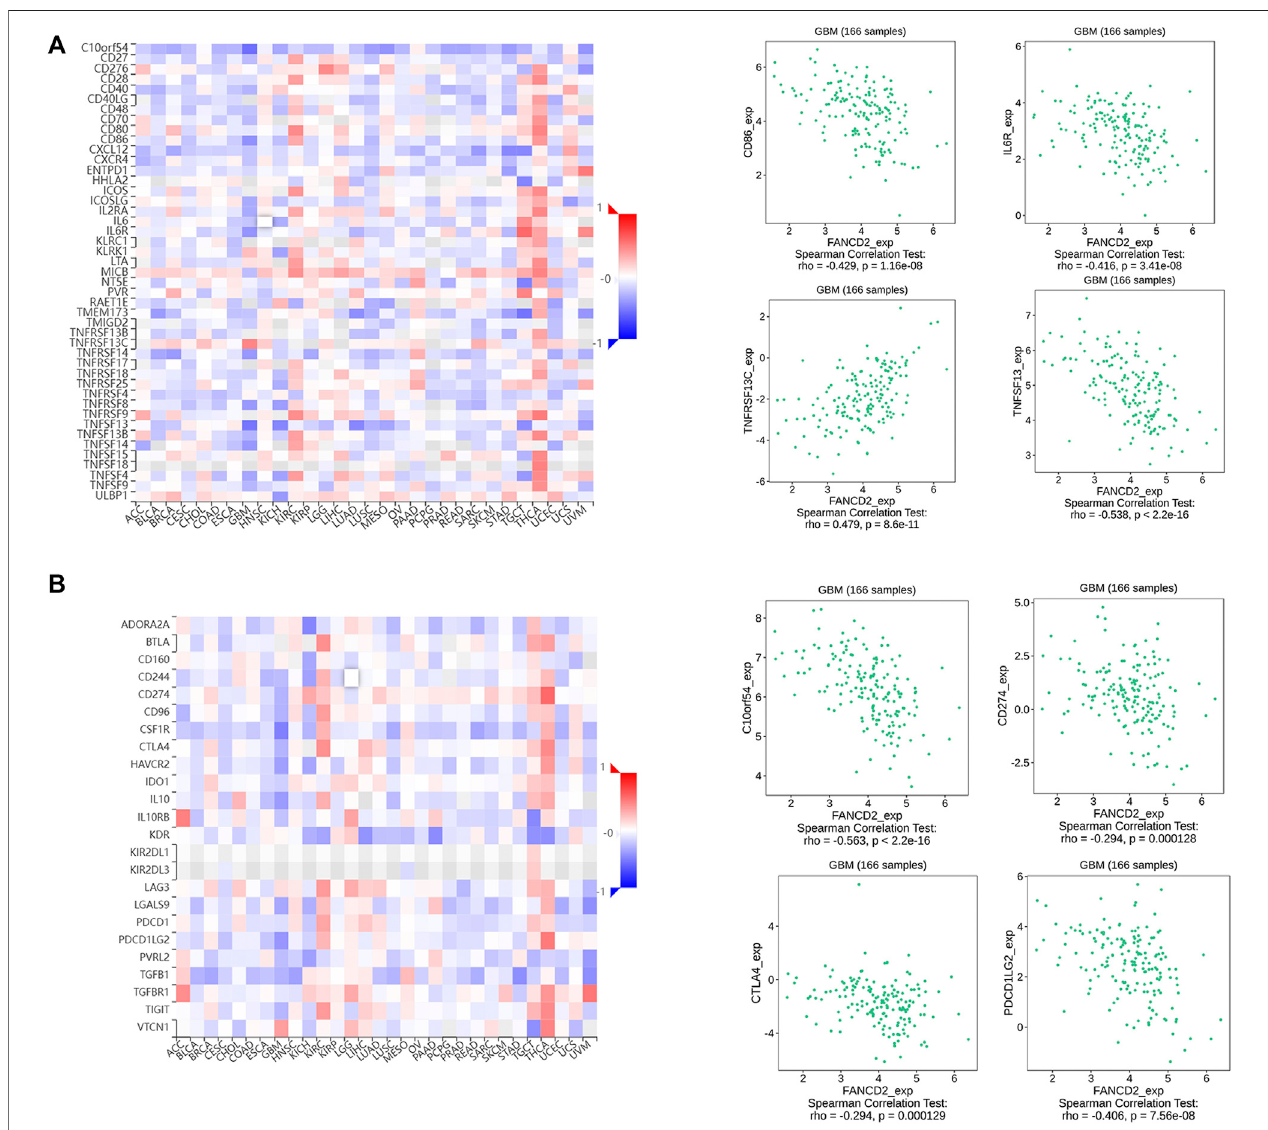
FIGURE 7 | Associations between FANCD2 expression and immunomodulators from the TISIDB database (A) The top four immune stimulators (CD86, IL6R, TNFSF13, and TNFSF14) negativelycorrelated withFANCD2 (B) Thetop four immune inhibitors (C10orf54, PDCD1LG2, CTLA4,and CD274)negativelycorrelated with